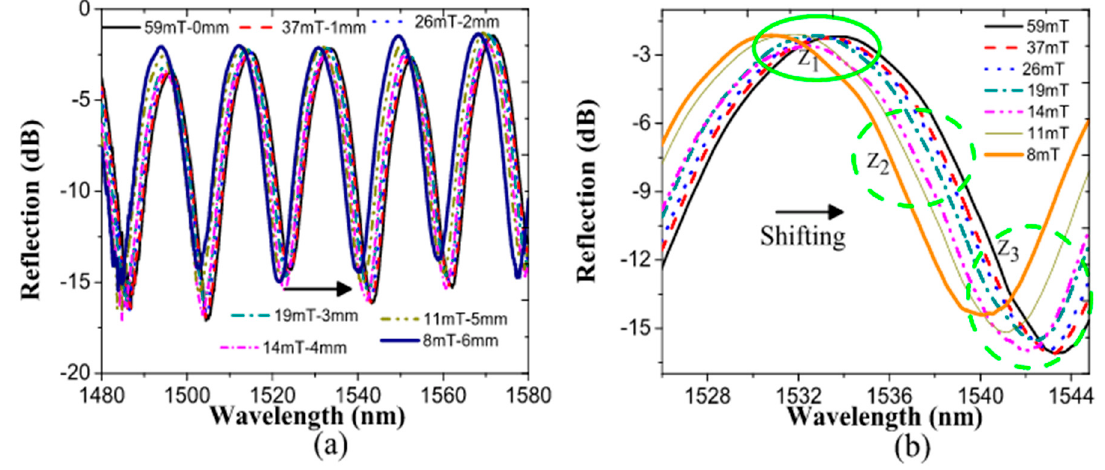
Figure 4. ( a ) Magnetic field response for specific magnet positions. ( b ) Particular fringe regions analyzed for magnetic field increments. Z 1 is near the signal maximum, Z 2 is where the signal’s slope change is the highest, and Z 3 is at the signal minimum.